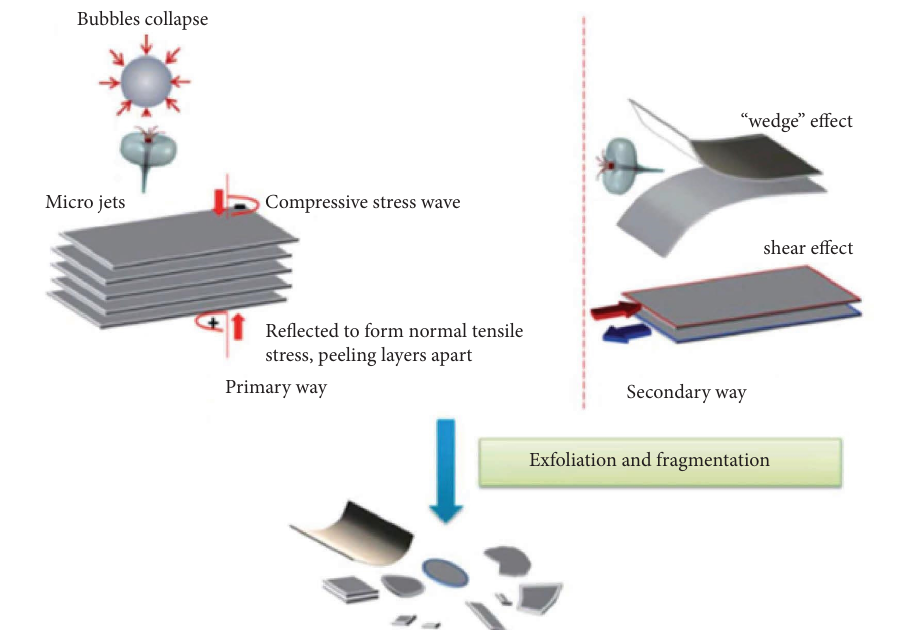
Figure 4: Working principle of sonication